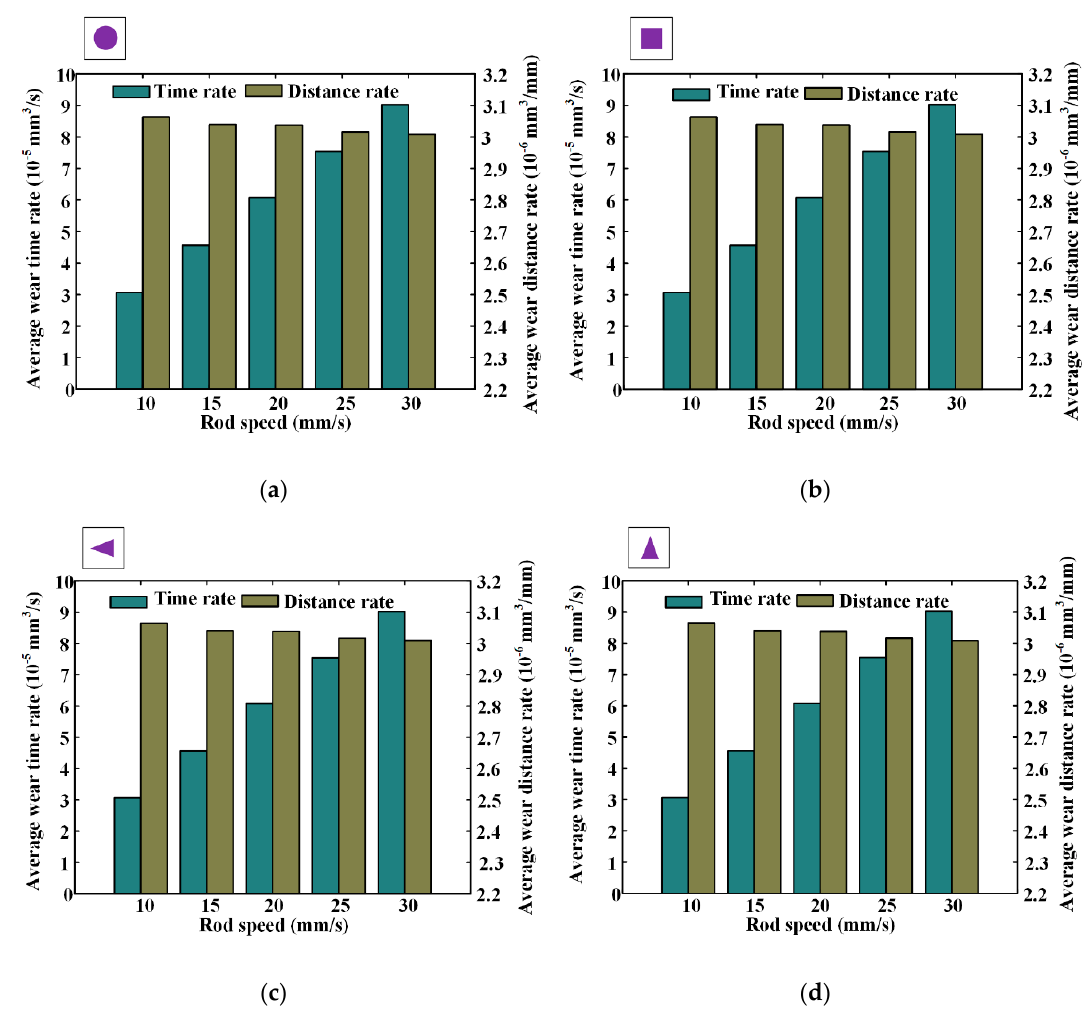
Figure 19. The wear rates under di ff erent rod speeds, ( a ) circle, ( b ) square, ( c ) triangle (Axial symmetry), ( d ) triangle (Circumferential symmetry).